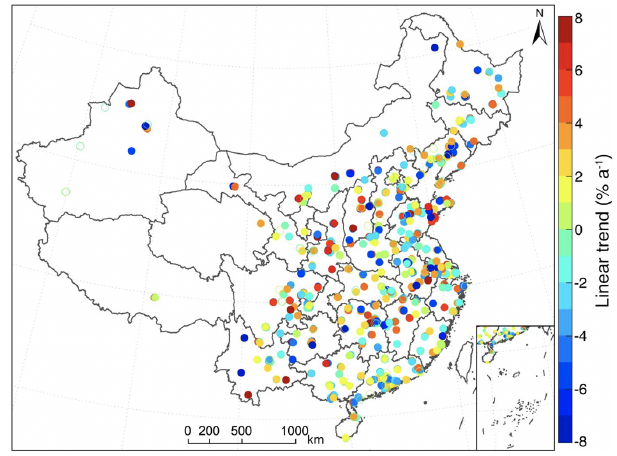
Figure 6. Trend estimations for the residual PM 2 . 5 concentration data series that failed to pass the homogeneity test during 2015– 2019 in the study area. The solid circles indicate trends are statisti- cally significant at the 95% confidence level.